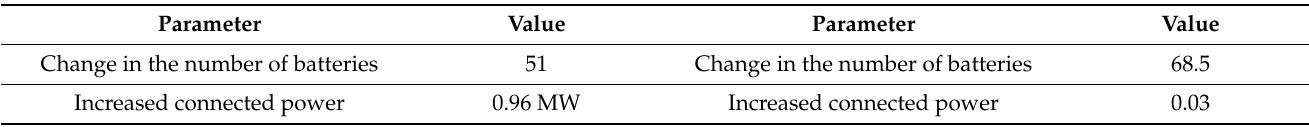
Table 10. Input parameters of the large battery storage strategy after 5 (left) and 10 (right) years.